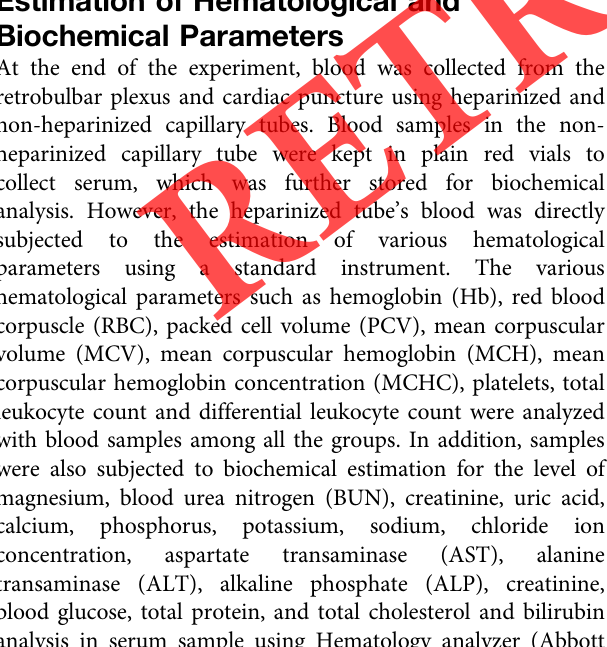
FIGURE 1 | Representative images of isolation of bacteriophages and XDR Klebsiella pneumoniae . (A) XDR clinical strain of Klebsiella pneumoniae , (B) Highcountofbacteriophage andits activity against Klebsiellapneumoniae on MHA plate, (C) Cultivation of Phage in Roux bottle, (D) Membrane dialysis of